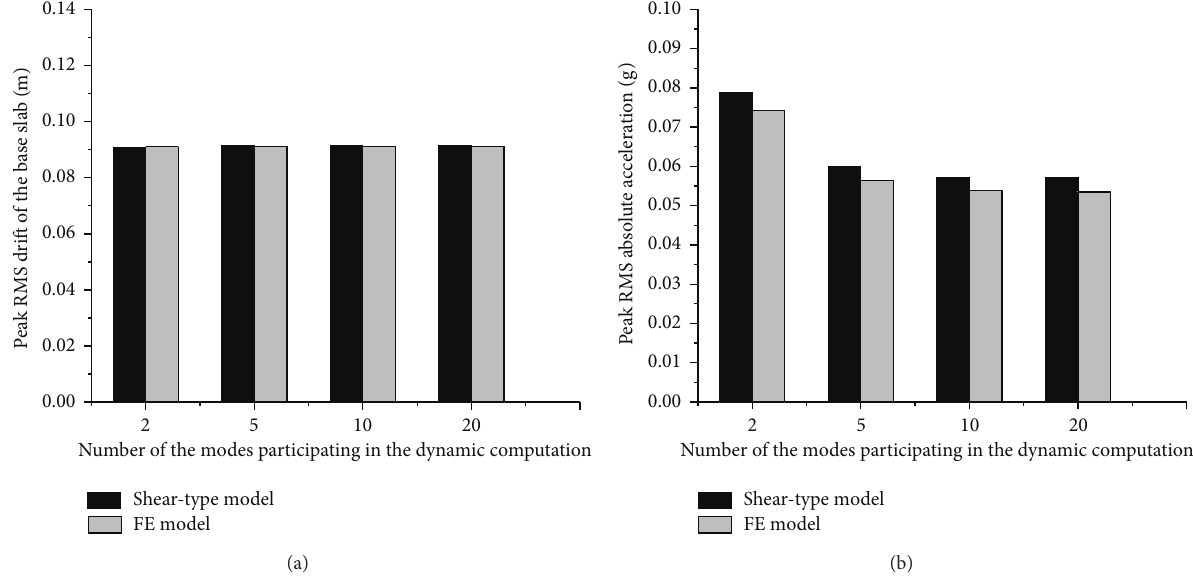
Figure 9: Influence of the number of the modes participating in dynamic computation on the (a) drift and (b) absolute acceleration of the base